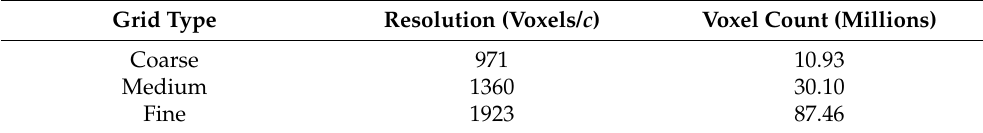
Table 1. Simulation domain specification for grid convergence